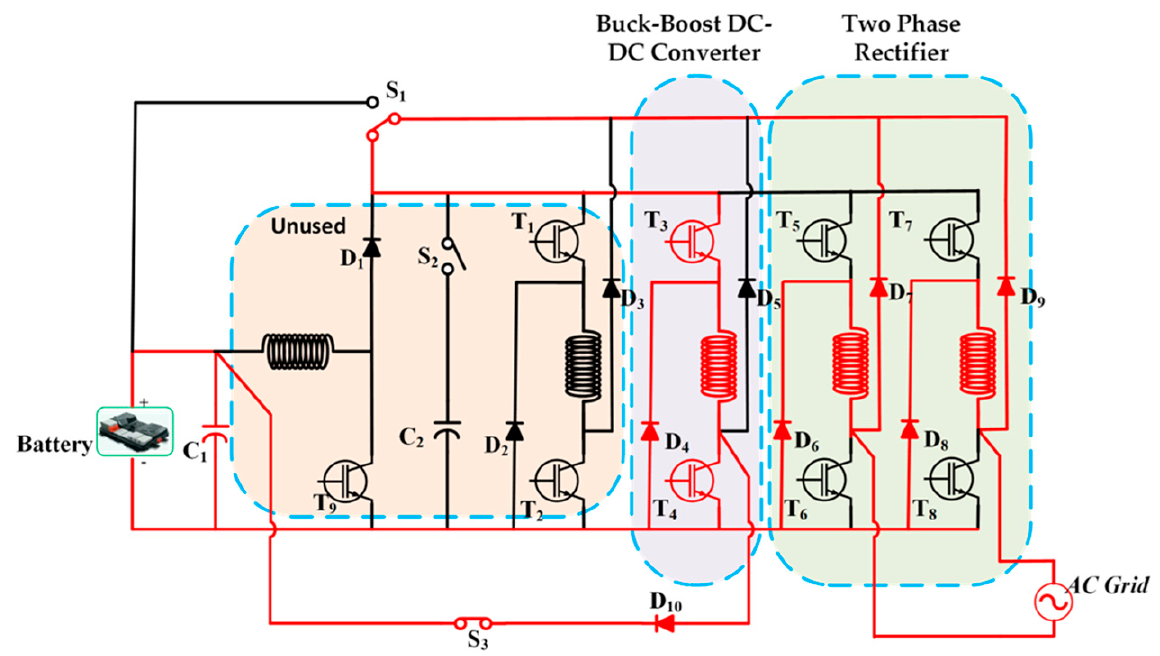
Figure 10. SRM drive integrated on − board charger proposed by Khayam Huseini et al. [68] in 2015. (iOBC6). The charging mode configuration is highlighted in red.